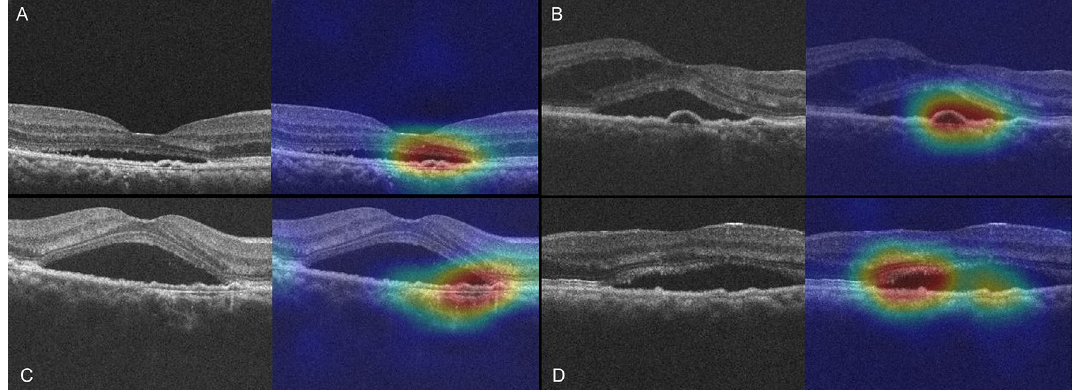
Figure 1. Four representative cases of persistent Grad-CAM analysis on B-scan. ( A – D ). The heatmaps highlight areas of shallow irregular pigment epithelial detachment in all cases. Areas of increased reflectivity representing elongated photoreceptor outer segments in the subretinal fluid area are shown in ( D ).